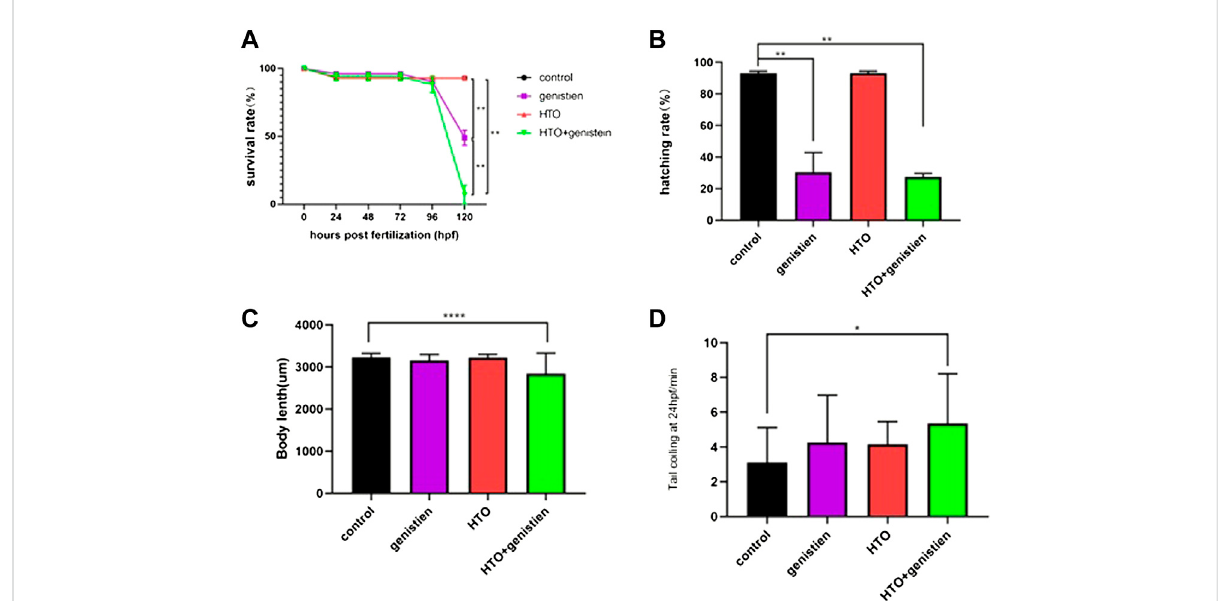
FIGURE 1 The growth and development of zebra fi sh during the exposure. (A) survival rate of zebra fi sh in each group at 120 hpf; (B) hatching rate of zebra fi sh embryos at 96 hpf; (C) the length of zebra fi sh larvae at 96 hpf; (D) spontaneous movement of the zebra fi sh embryo tail at 24 hpf. 10 samples were taken from each parallel samples of each experimental group. * p < 0.05, ** p < 0.01, **** p < 0.0001.